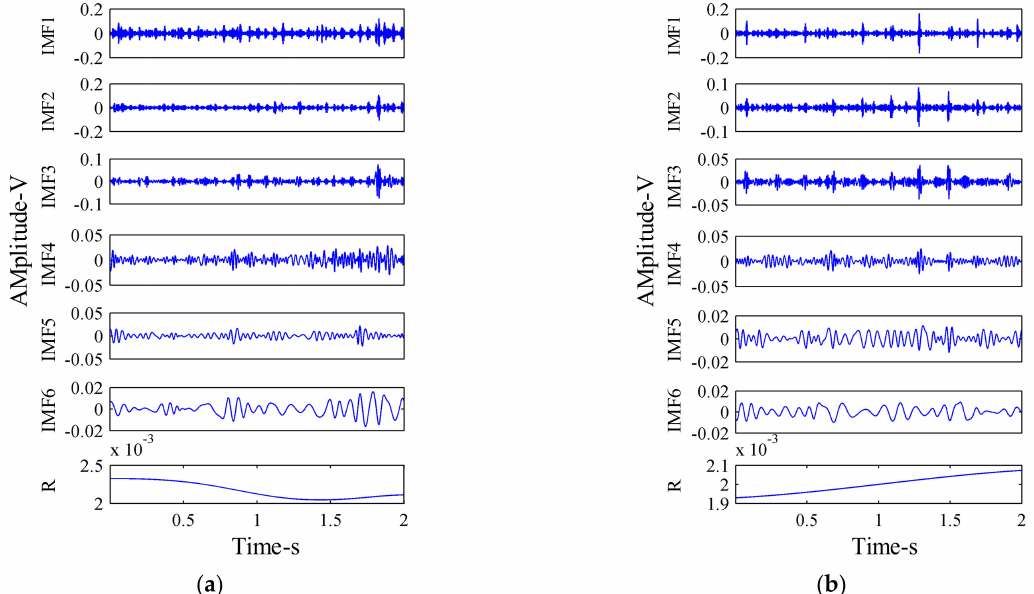
Figure 11. MEEMD decomposition results of vibration signal: ( a ) Normal working state; and ( b ) Single slipper wear fault